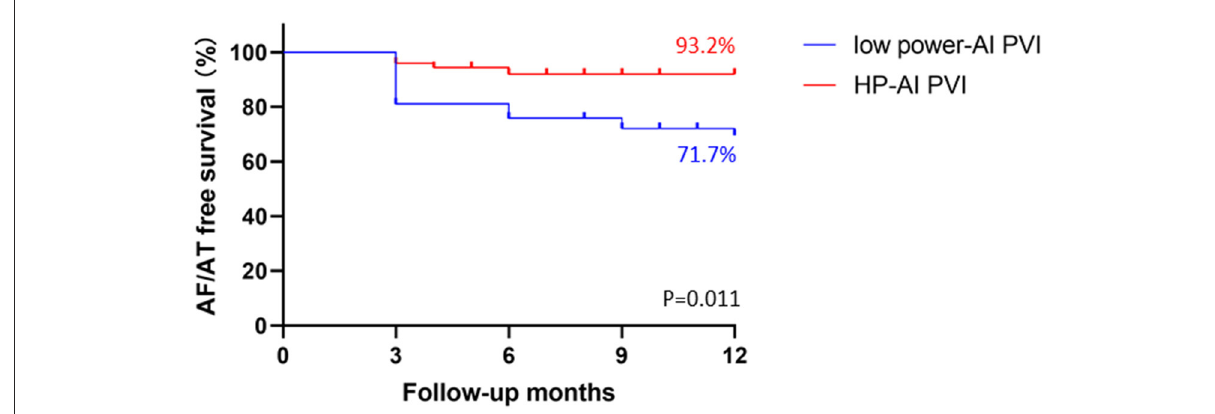
FIGURE4 Kaplan–Meier curves of the HP-AI and low power-AI groups.